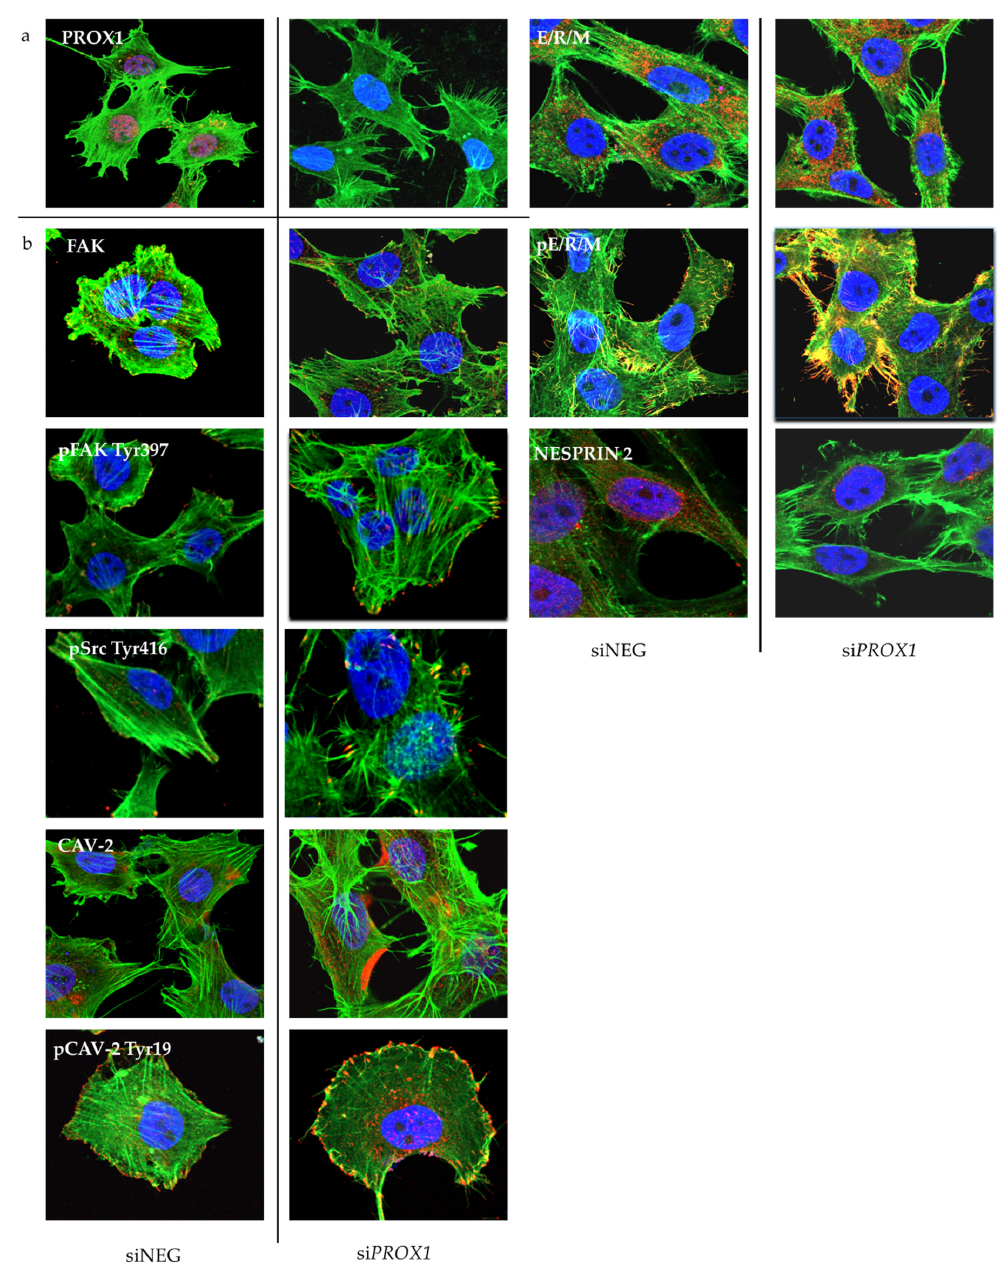
Figure 5. PROX1 knock-down induced changes in the organization of the actin cytoskeleton, the cell shape, the filopodia extension and the cell-cell adhesion. Representative confocal microscopy images displaying expression levels and cellular localization of PROX1 ( a ) and the following immunofluorescently labelled signalling proteins involved in the cell migration, focal adhesion and cytoskeleton organization after PROX1 silencing with PROX1-specific or negative siRNA ( b ) taken at a 1000× magnification are shown. siNEG: negative control (cells transfected with negative siRNA). CGTH cells were immunofluorescently labelled with DAPI (4 ′ ,6-diamidino-2-phenylindole; nuclear staining, blue), FITC-phalloidine (fluorescein isothiocyanate; F-actin, green) and with relevant DyLight ® 594 or with Rhodamine Red (red)-conjugated secondary antibodies.